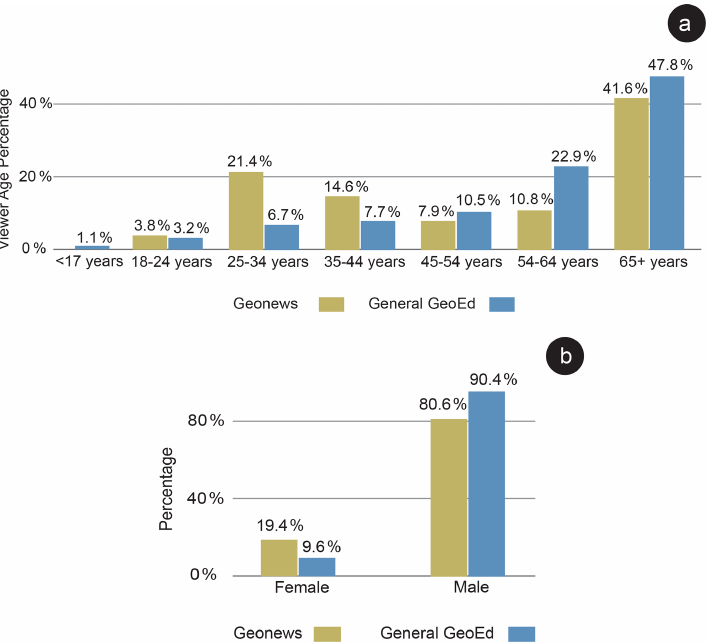
Figure 3. Histogram of viewer ages (a) and gender (b) of Geonews and General GeoEd videos. The data are from 167000 views of